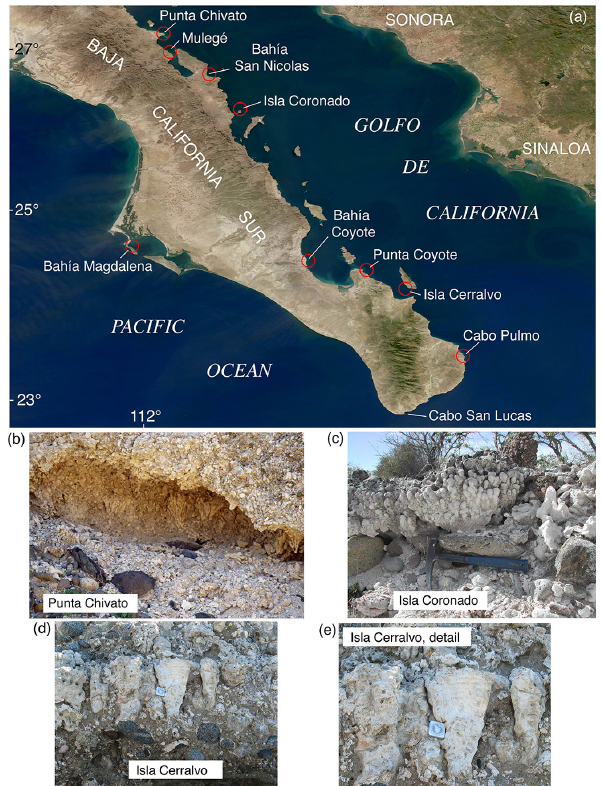
Figure 32. (a) Satellite image of southernmost Baja California Sur and parts of Sonora and Sinaloa, acquired on 27 November 2011 using the MODIS instrument on the Aqua satellite (courtesy of the NASA Rapid Response Team). Red circles indicate marine terrace localities where U-series ages on corals have yielded MIS 5e ages (see Table S1). (b–e) Photographs of growth-position corals dated to MIS 5e from Punta Chivato, Isla Coronado, and Isla Cerralvo (see Johnson, 2002; Johnson et al., 2007; Tierney and Johnson, 2012). All coral photographs are courtesy of Markes Johnson, Williams College.